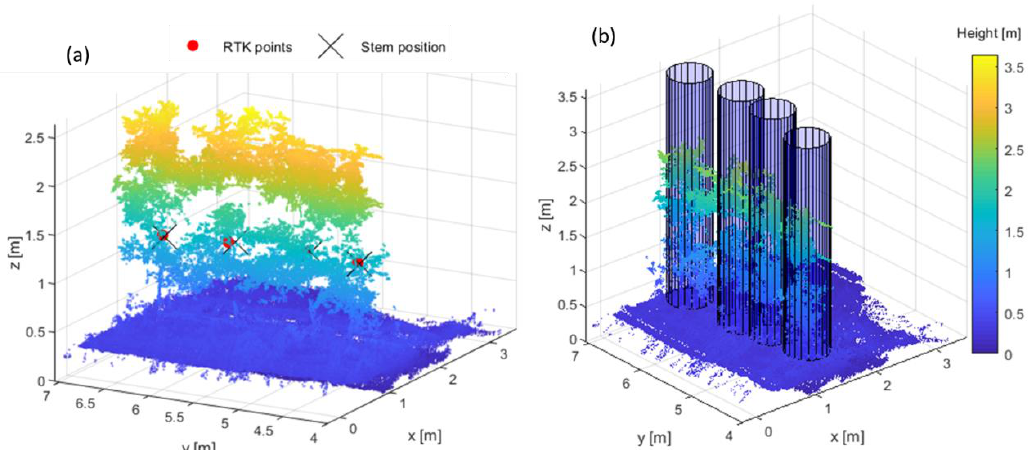
Figure 7. ( a ) Merged point cloud with estimated stem position and stem position defined by RTK-GNSS. For illustration purposes, only first part of row 1 is represented. ( b ) Projected cylinders for single tree segmentation based on the estimated stem position.